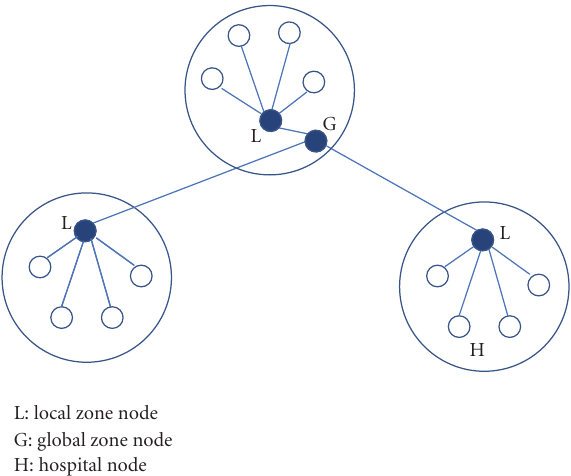
Figure 6: Realizing global space within and across